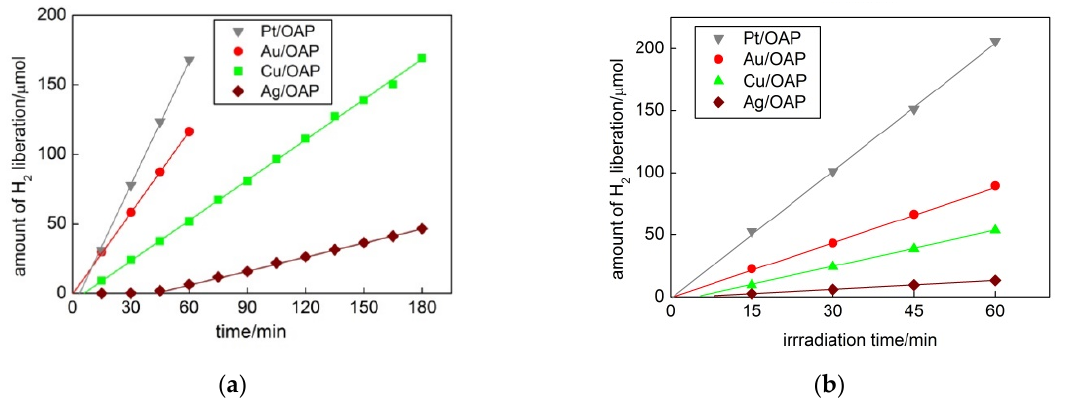
Figure 2. Hydrogen evolution on octahedral anatase particles (OAP): ( a ) during metal deposition; ( b ) after metal deposi-